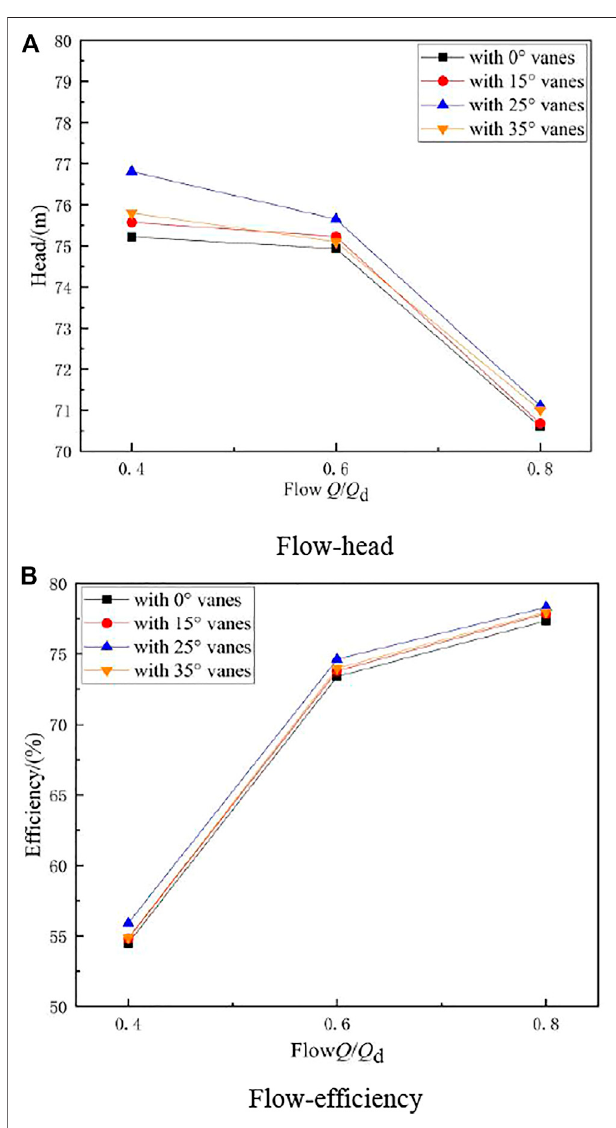
FIGURE5| Externalcharacteristics ofcentrifugalpumps: (A) fl ow-head; (B) fl ow-ef fi ciency.